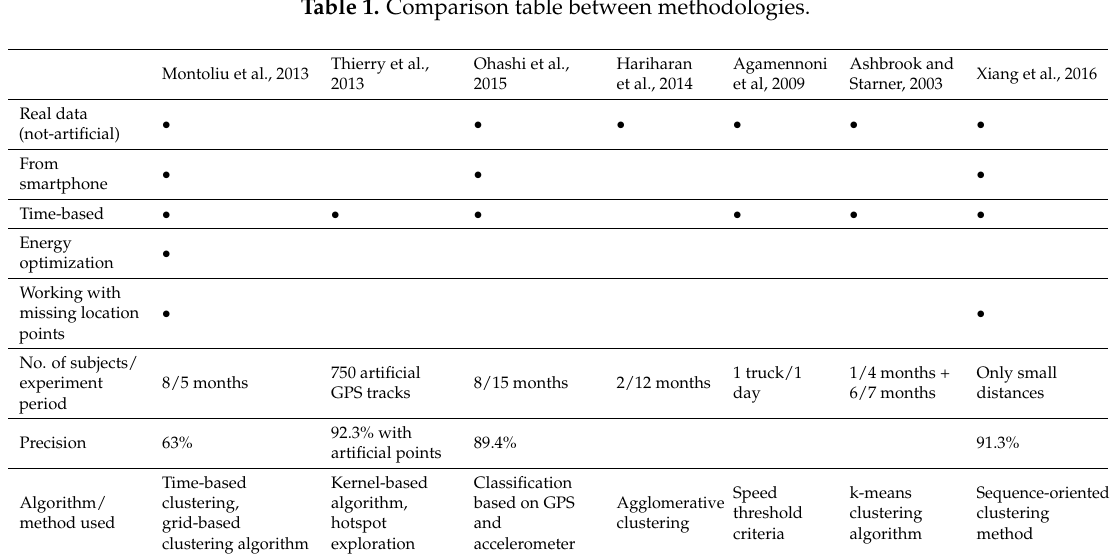
Table 1. Comparison table between